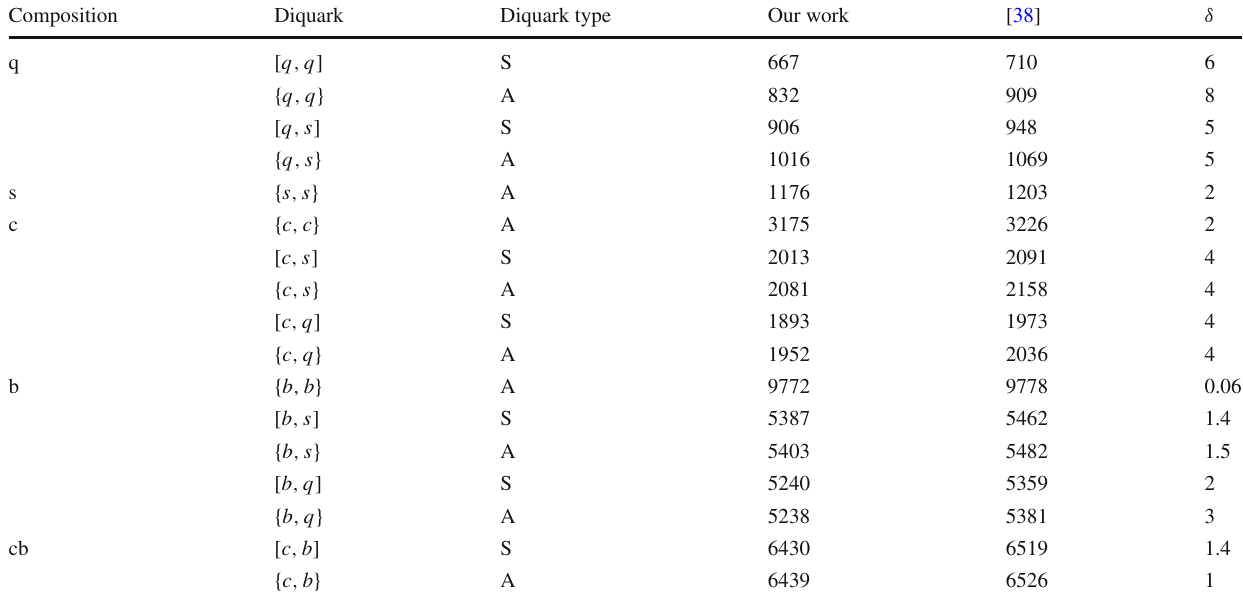
Table2 ThemassesofconventionaldiquarksarecalculatedinunitsofMeV.SandAdenotescalarandaxialvectordiquarkswhichareantisymmetric [···] and symmetric {···} in flavour, respectively. δ is the percentage difference between our results and [38] Composition Diquark Our work